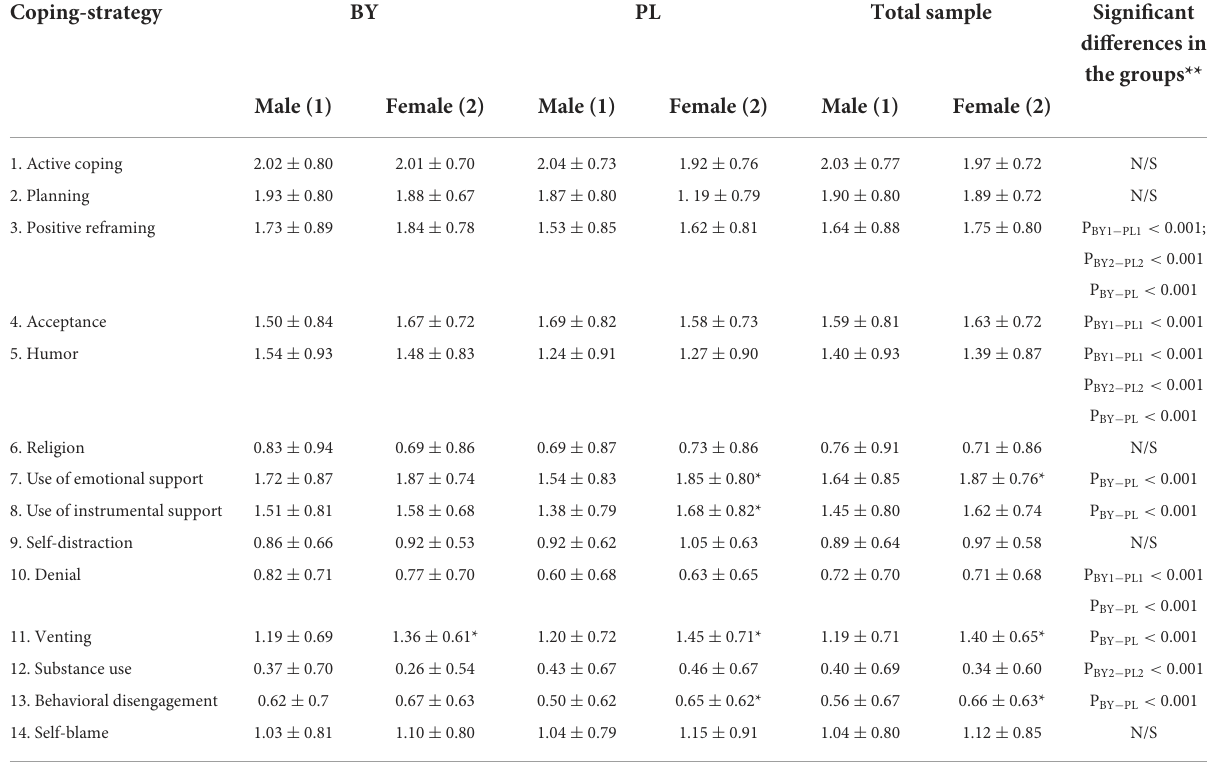
differences in the